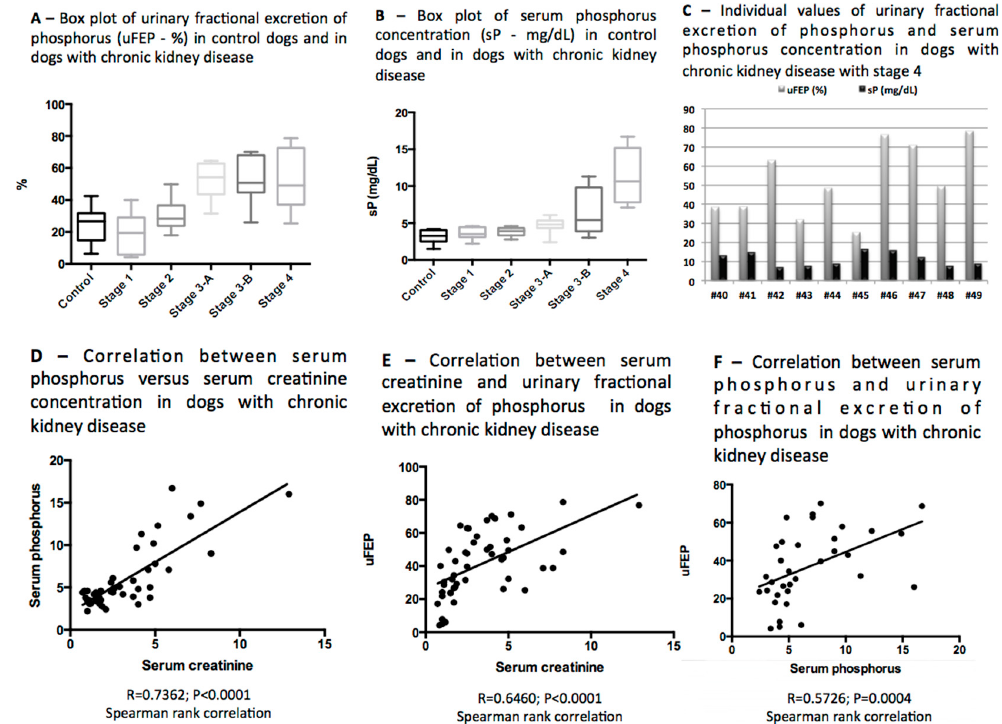
Figure 1. ( A ) Box plot of urinary fractional excretion of phosphorus (uFEP; %); ( B ) Box plot of serum phosphorus concentration (mg/dL); ( C ) individual values of urinary fractional excretion of phosphorus (%) and serum phosphorus concentration (mg/dL) in dogs with chronic kidney disease with stage 4; ( D ) correlation between serum phosphorus (mg/dL) and serum creatinine concentration (mg/dL) in dogs with chronic kidney disease; ( E ) correlation between serum creatinine (mg/dL) and urinary fractional excretion of phosphorus (%) in dogs with chronic kidney disease; ( F ) correlation between serum phosphorus (mg/dL) and urinary fractional excretion of phosphorus (%) in dogs with chronic kidney disease.